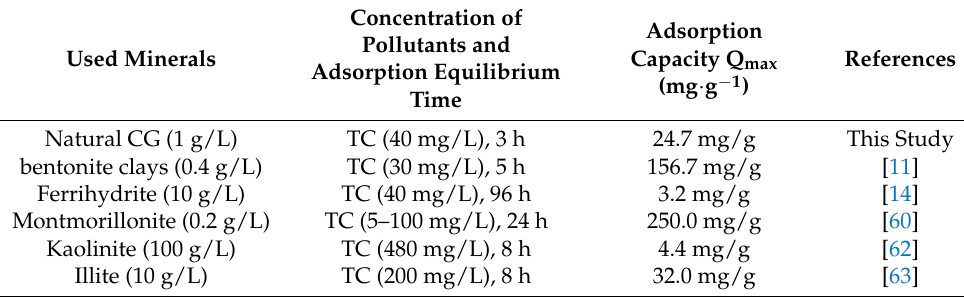
Table 2. The comparisons of TC adsorption between CG and other minerals. Concentration of Adsorption Pollutants and Capacity Q max Used Minerals Adsorption Equilibrium (mg · g − 1 ) Time Natural CG (1 g/L) TC (40 mg/L), 3 h 24.7 mg/g This Study bentonite clays (0.4 g/L) Ferrihydrite (10 g/L)